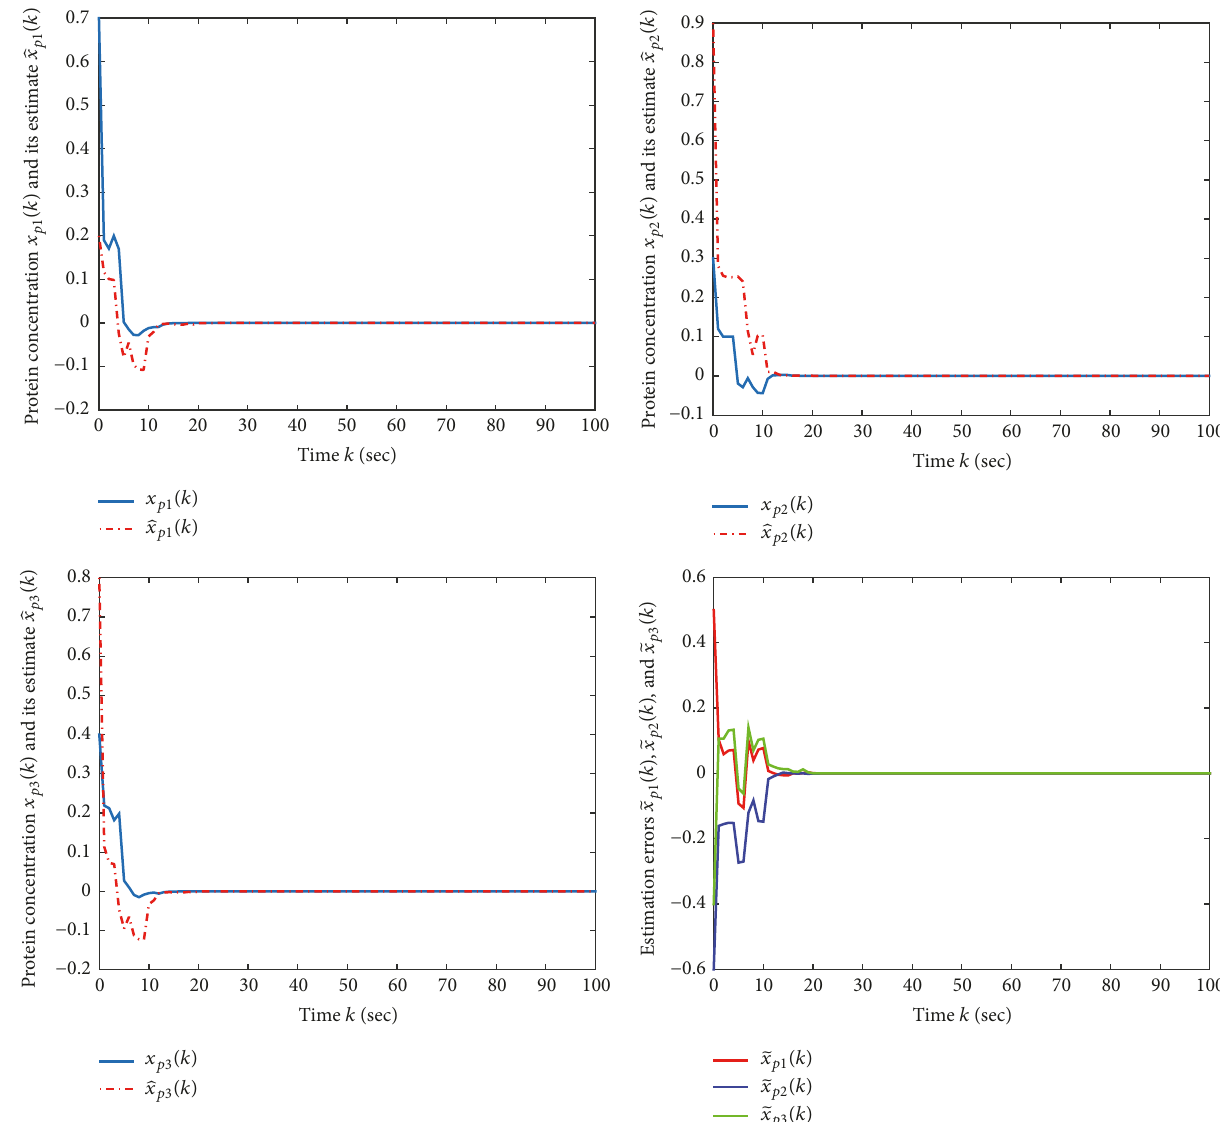
−0.6−0.4−0.200.20.40.6